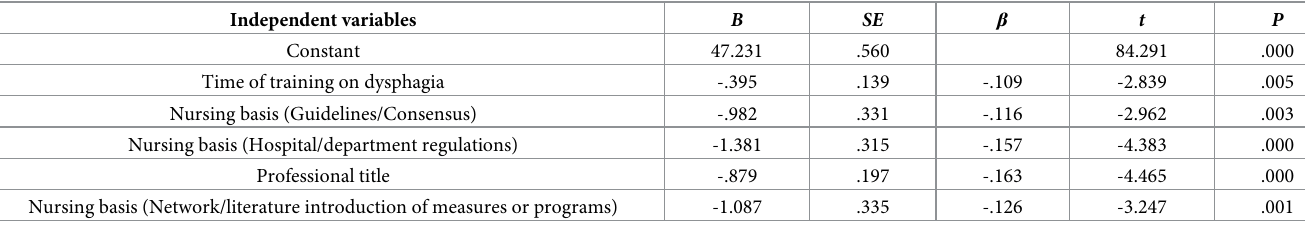
Table 4. Regression analysis of knowledge of neurological nurses in